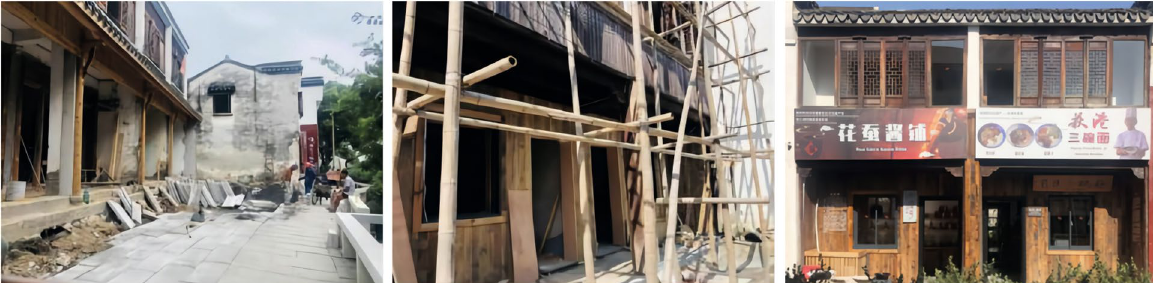
Fig. 4 Changes to Digang Food Street before (left) and after (middle and right) adaptation (Source: provided by the Digang Fish Restaurant)